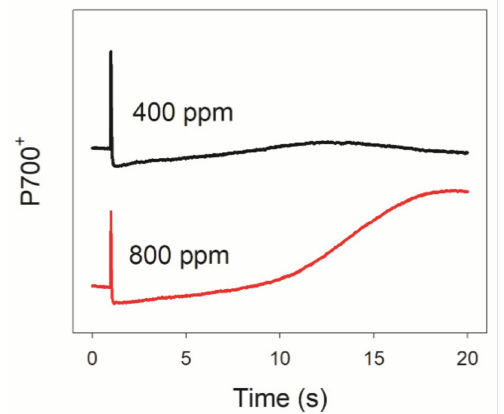
Figure 1. Changes in P700 redox kinetics after transition from darkness to actinic light (1809 µ mol photons m − 2 s − 1 ) in 400 and 800 ppm atmospheric CO 2 . Data are shown as mean values of five leaves from five individual